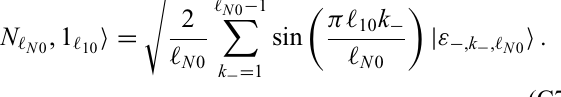
FIG. 6. Schematic representation of the block structure of the states at first order in a chain with a quasiparticle and a boson, here presented for L = 4. In the left (right) column, the boson is located to the left (right) of the quasiparticle. The arrows rep- resent possible couplings between blocks at orders less than or equal to N + 2. As discussed in the text, the vertical gray arrows are never active since the corresponding blocks do not share any first-order energies. Moreover, depending on the particular first- order eigenspace under consideration, either the red or the blue arrows are inactive due to the same reason. This means that up to ( N + 2 ) nd order, the zeroth-order eigenstates are always a mixture of states from exactly two